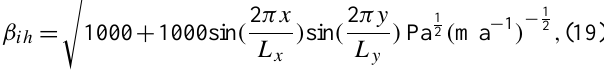
Fig. 2. Same as Fig. 1, with domain length of 20km. Initial guess for β 2 set uniformly to 20Pa